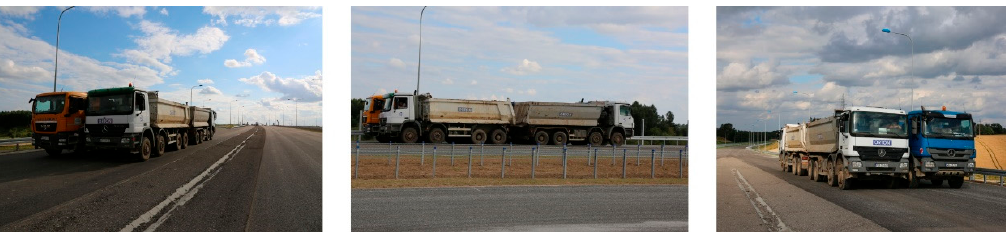
Figure 10. The trucks, positioned during the S2 test configuration. Views from three different perspectives.